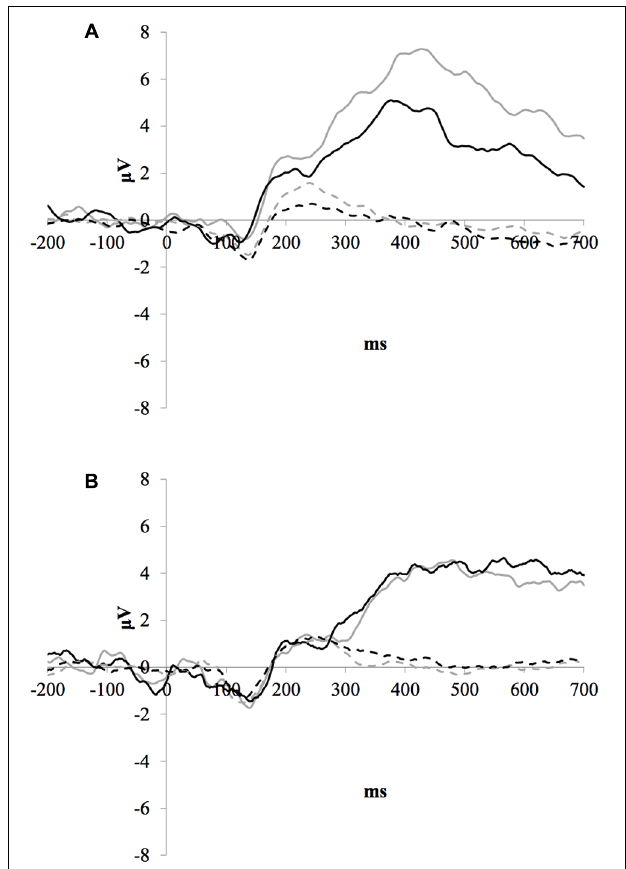
FIGURE 1 | (A) Grand average ERP waveforms of the oddball (solid line) and frequent (dotted line) stimuli for the trained group at baseline (gray line) and post-test (black line) at electrode Pz. (B) Grand average ERP waveforms of the oddball (solid line) and frequent (dotted line) stimuli for the control group at baseline (gray line) and post-test (black line) at electrode Pz.